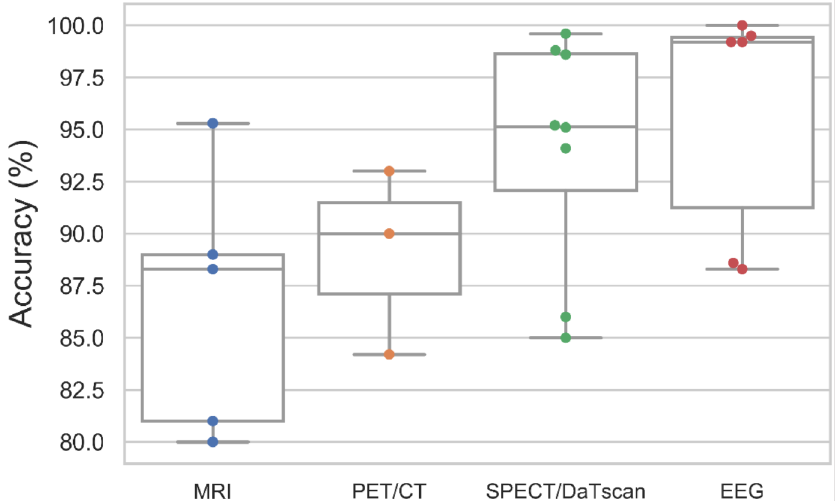
Figure 6. Box and whiskers plot of the model accuracy of deep learning studies using various modalities of brain